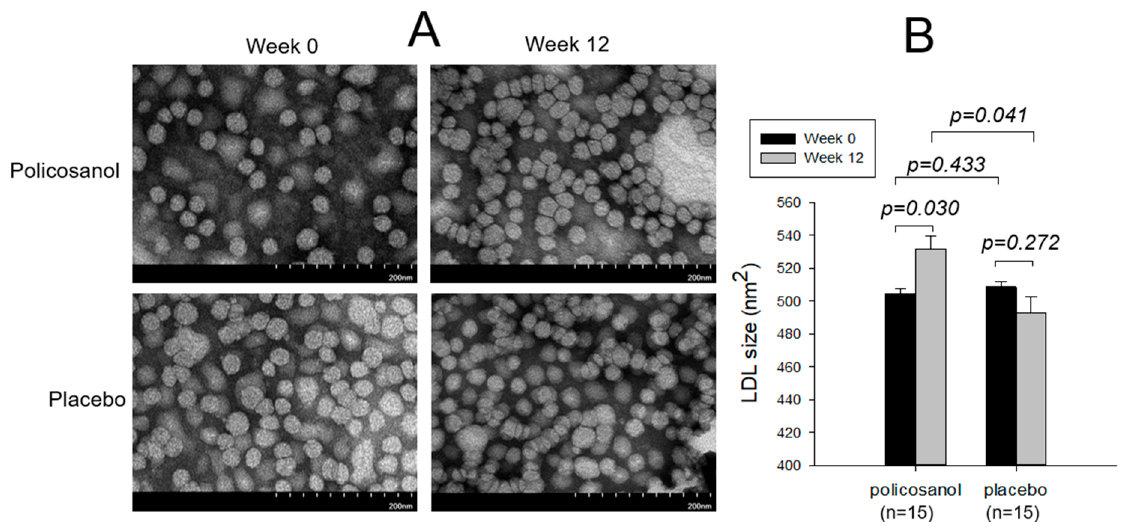
Figure 3. TEM image of LDL ( A ) at a magnification with 40,000× and area analysis ( B ) of LDL from each group between weeks 0 and 12. LDL particle size in each group between weeks 0 and 12 was compared by a paired t -test. One graduation of the scale bar indicates 20 nm.